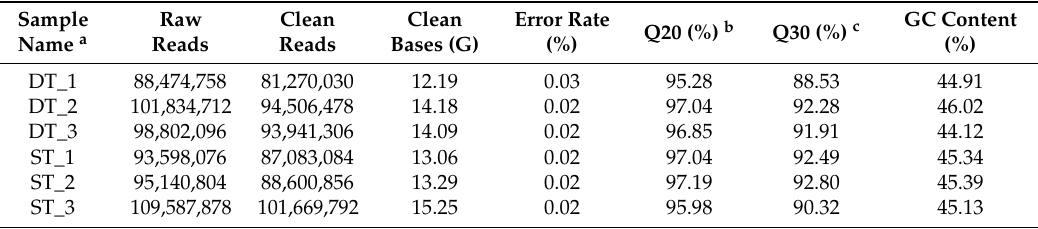
Table 1. Summary of potato dormant tubers (DTs) and sprouting tubers (STs) transcriptome sequencing results.